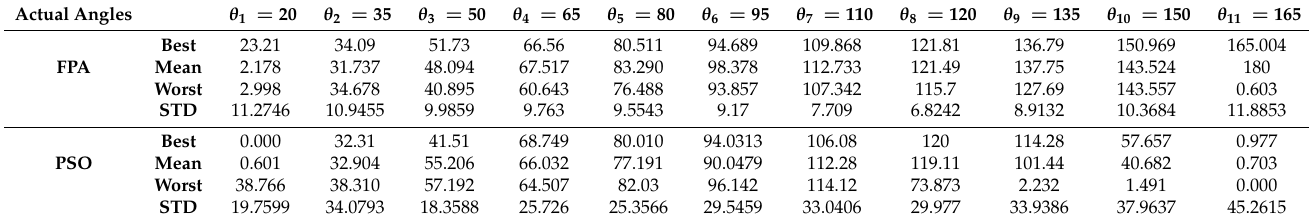
Table 8. Estimation accuracy and STD for eleven targets at SNR = − 5 dB.